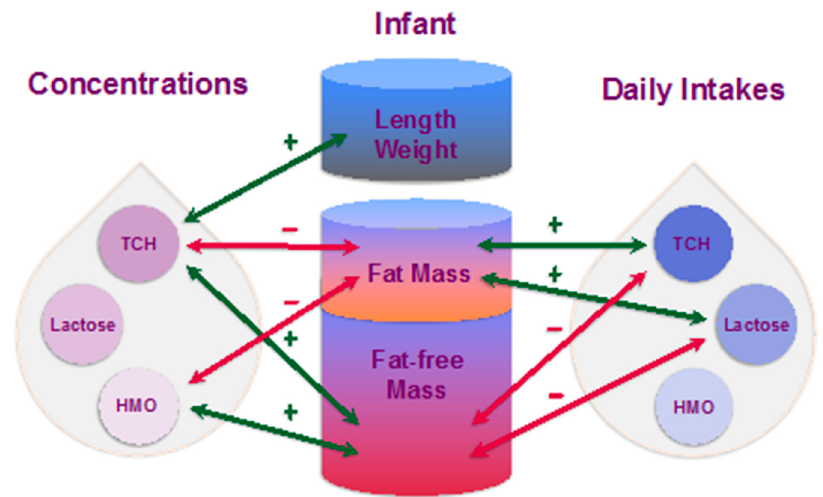
Figure 5. Suggested lactocrine programming of the infant body composition during first 12 months of life. Green arrows indicate positive associations of human milk carbohydrates (concentrations and calculated daily intakes) with infant body composition parameters and red arrows—negative associations. HMO: human milk oligosaccharides; TCH: total